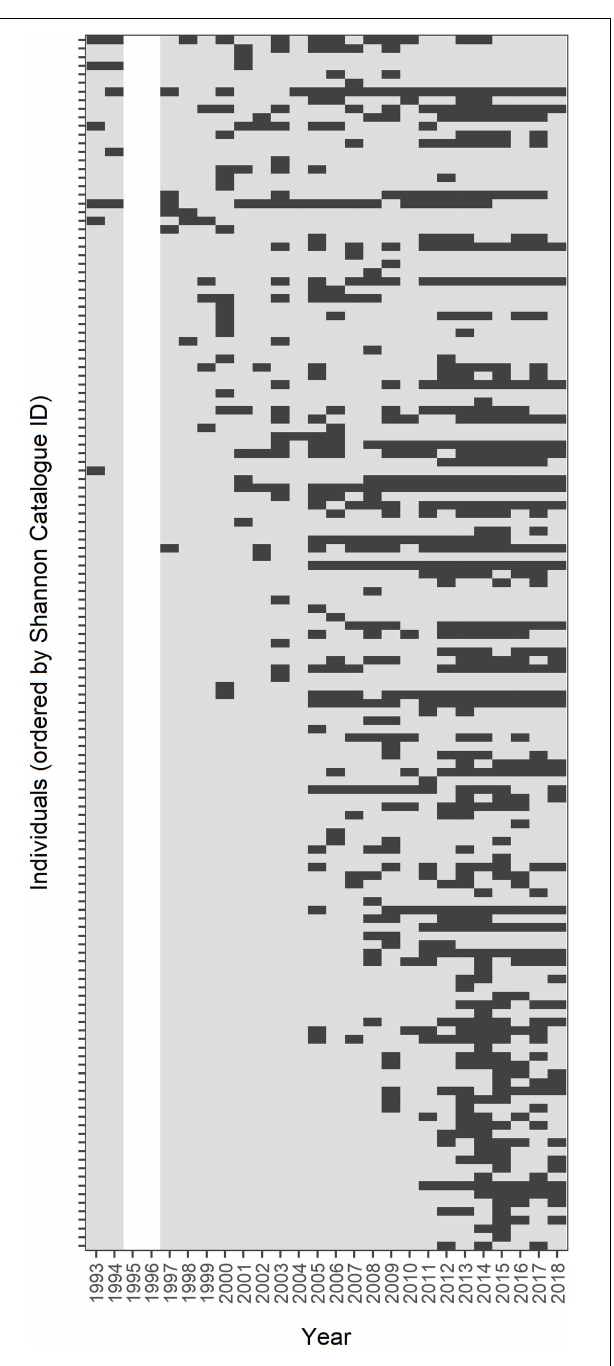
FIGURE 3 | Encounter histories of 141 Shannon bottlenose dolphins, ordered by their ID-codes in the Shannon Catalogue. Each row represents the encounter history of one individual, dark-grey rectangles represent “presence” while light-grey rectangles represent “absence.” The blank cells for 1995/1996 indicate absence of data for these